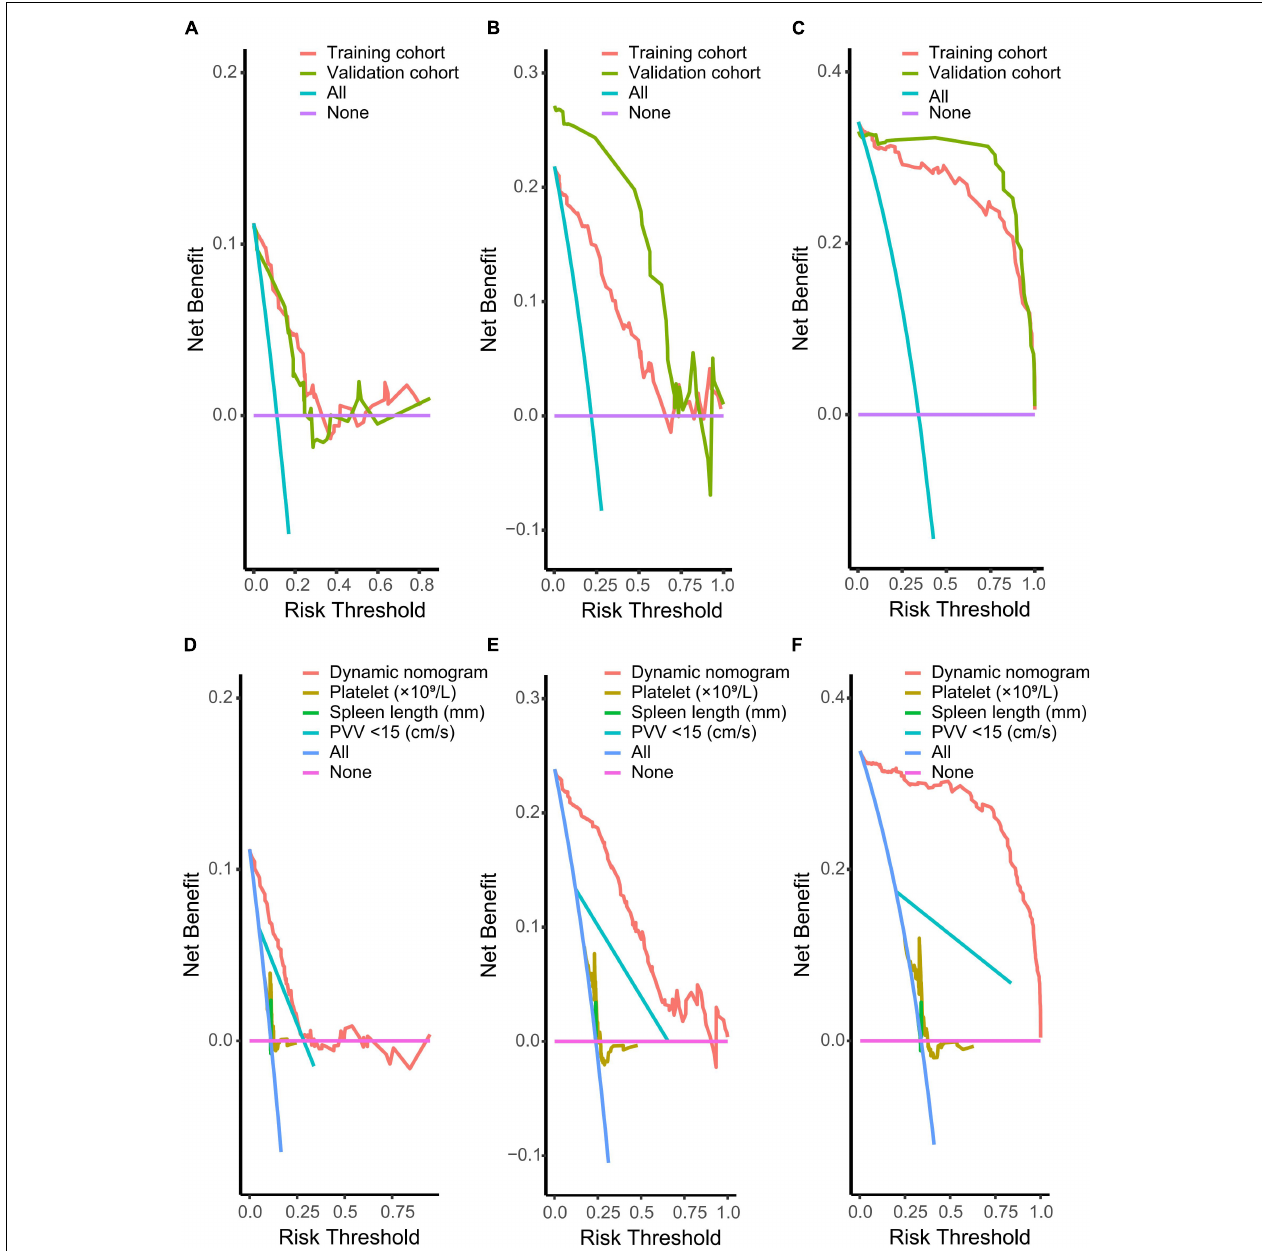
FIGURE 6 | Decision curve analysis implicating the net benefit with respect to the use of the nomogram for predicting 1, 2, and 3-year PVT. (A–C) Decision curve analysis of nomogram for predicting PVT in both training and validation cohorts ( n = 169 and n = 99, respectively). (D–F) Decision curve analysis of nomogram and other factors for predicting PVT in the whole cohort ( n = 268). The X -axis represents the threshold probabilities, and the Y -axis measures the net benefit calculated by adding the true positives and subtracting the false positives. The horizontal line (None) along the X -axis assumed that PVT occurred in no patients, whereas the solid slant line (All) assumed that all patients will have PVT at a specific threshold probability. Other corresponding lines represented the net benefit of using the nomogram and other factors.